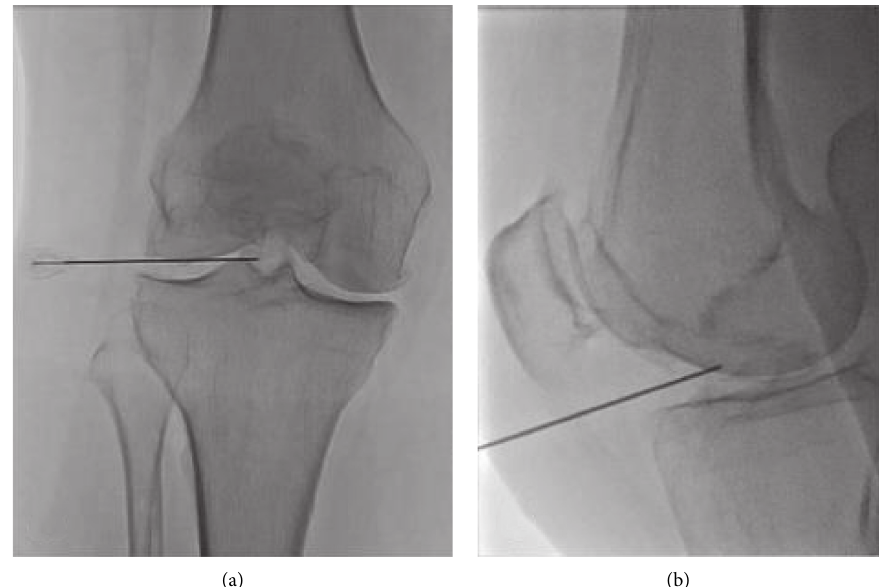
Figure 1: (a) Face fluoroscopy view illustrating the final position of the trocar at the level of the tibial crest. (b) Lateral fluoroscopy view illustrating the final position of the trocar anteriorly to the tibial crest.